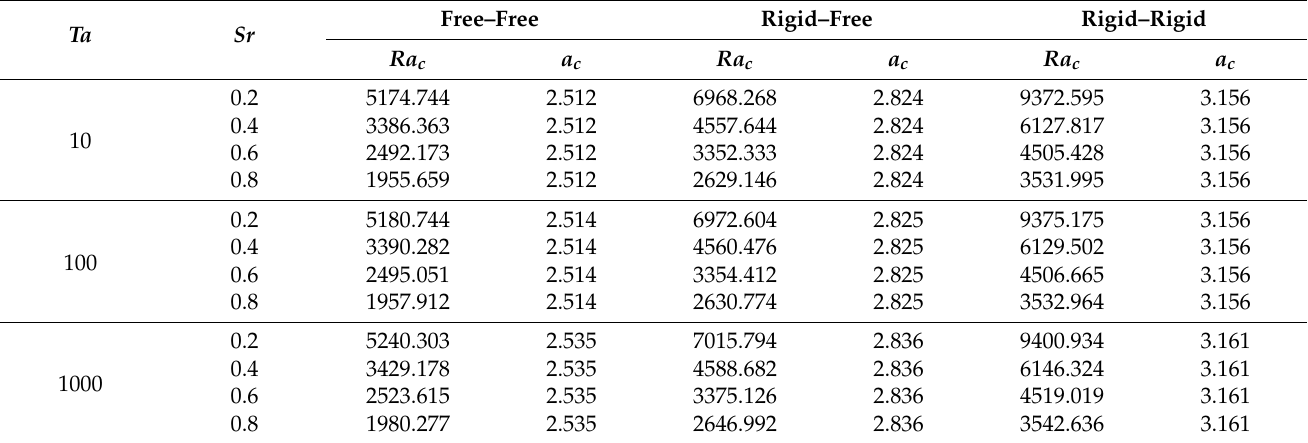
Figure 11. Variation of a c with Ta for Sr = 0.2, Du = 0.02, Rs = 200, Le = 5, Λ = 8, M = 0.9, ϕ = 0.9. Table 3. Critical values of Ra and a for Da = 0.01, Du = 0.02, Rs = 200, Le = 5, Λ = 8, M = 0.9, φ = 0.9.